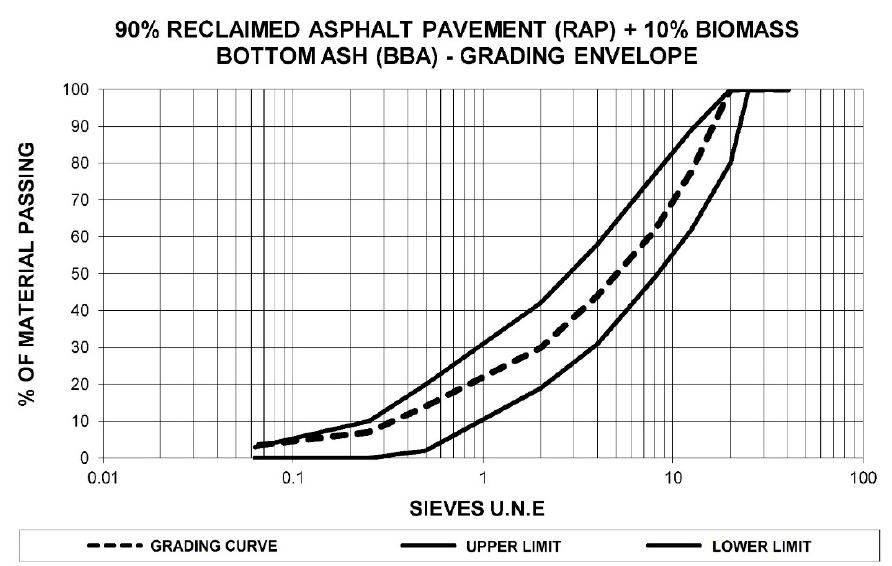
Figure 4. Graph of the grading curve for the combination of 90% RAP and 10% BBA, referenced to the grading envelope of Circular 8/2001 [31].